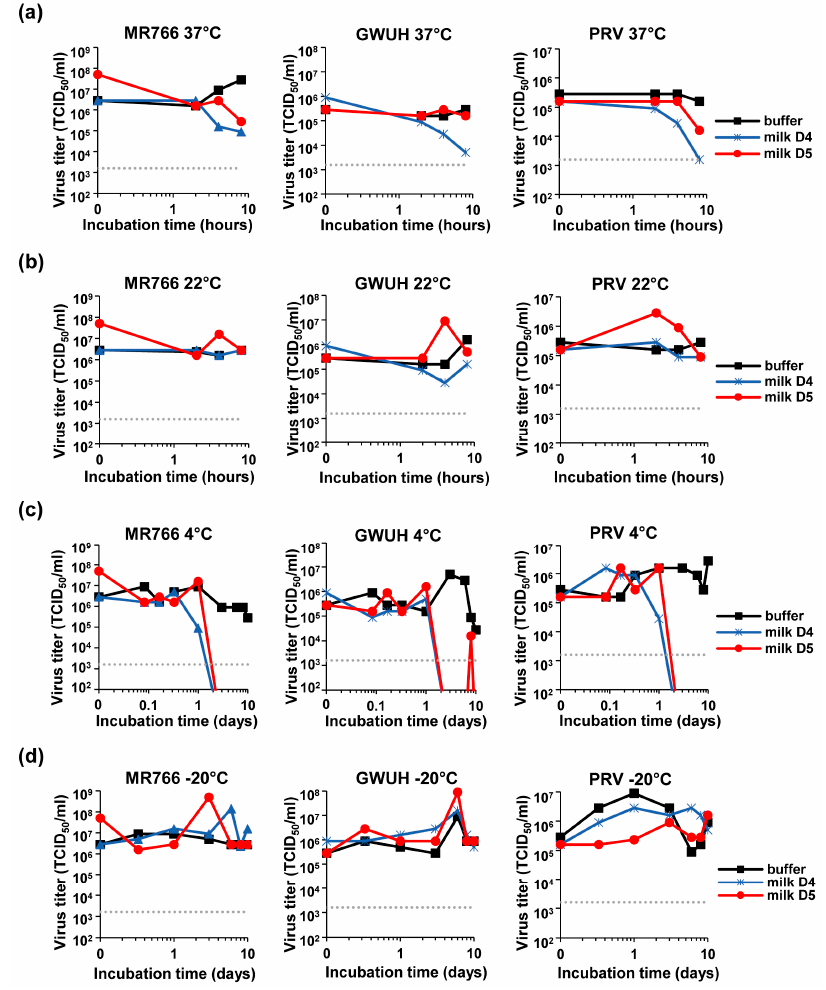
Figure 6. Determination of the ZIKV titer after the incubation of the virions in breast milk at di ff erent temperatures. ZIKV MR766, GWUH, or PRV were spiked into buffer or fresh breast milk that